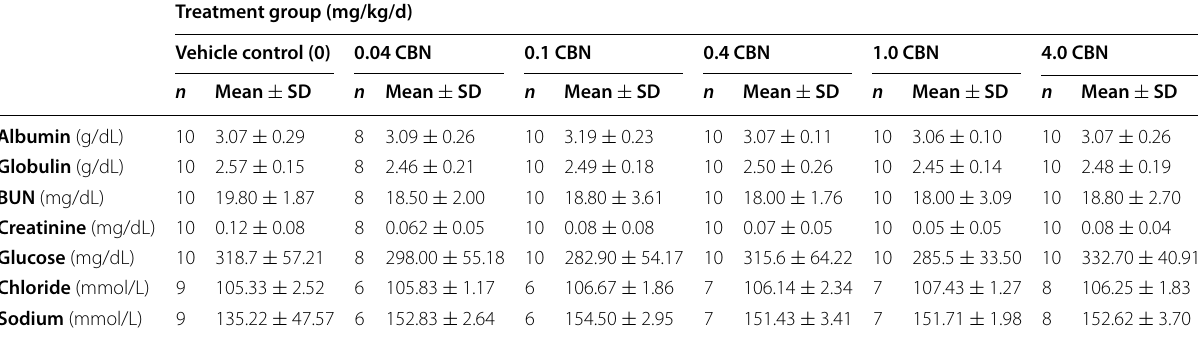
CBN Cannabinol, CBNT CBNight ™ , d day, dL deciliter, g gram, kg kilogram, L liter, mg milligram, mmol millimole, n , number, SD standard deviation